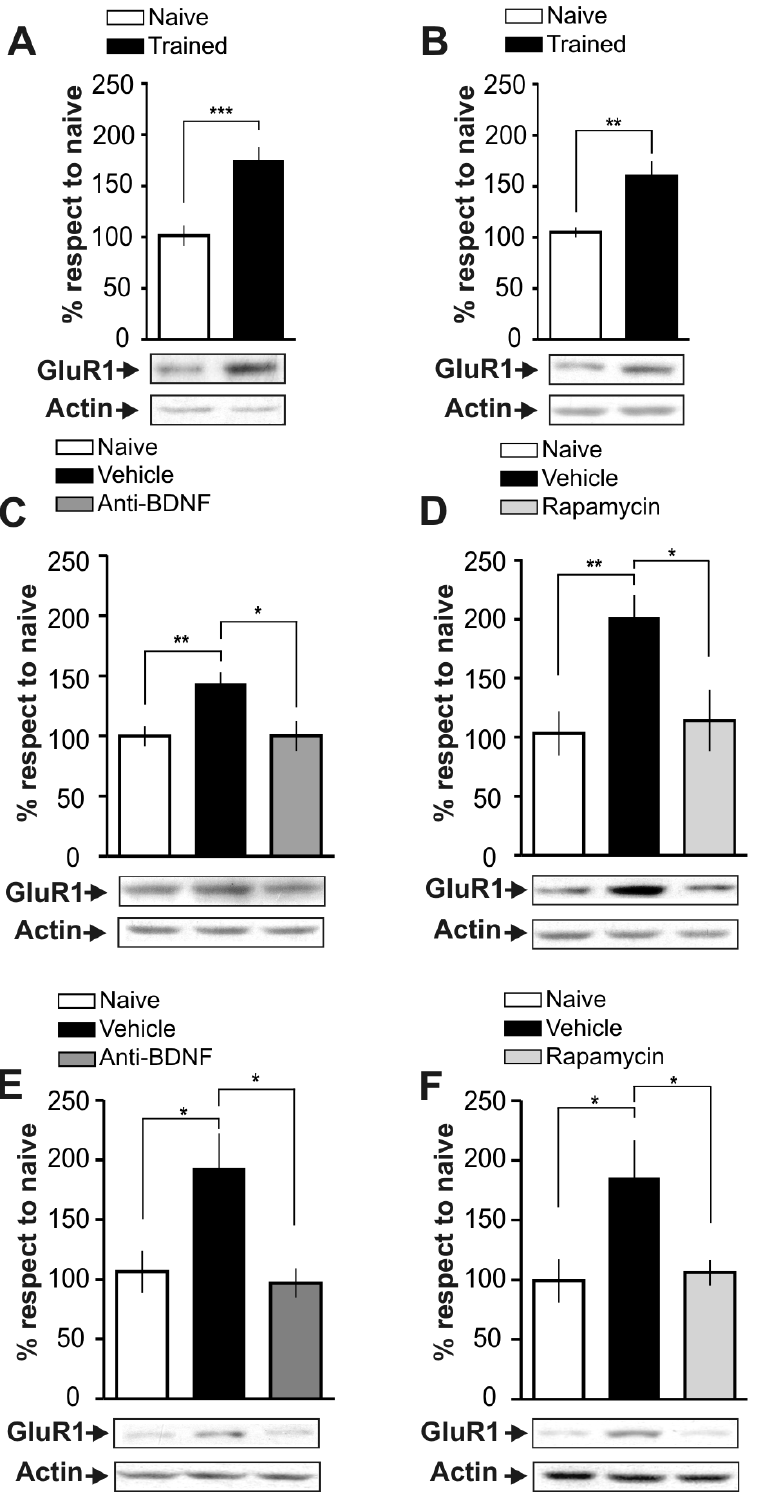
Figure 6. IA Training Induces GluR1 Expression in Hippocampal Synaptic Plasma Membranes-Enriched Fractions Through BDNF/ mTOR Pathway. Bars represent the mean GluR1/actin ratio from synaptic plasma membranes-enriched fractions obtained from samples of the dorsal hippocampus of trained (black) respect to naı¨ve (white) rats 15 min (A) or 3 h after IA training (B). Rats infused intra-CA1 of the dorsal hippocampus 15 min before and sacrificed 15 min after training (B and C) or 2:45 h and sacrificed 3 h both after training (E and F) with vehicle (black) or function-blocking anti-BDNF antibodies (0.5 m g/side; dark grey) (C and E) or rapamycin (4.3 pg/side; light grey) (D and F). Representative blots of total GluR1 protein levels and actin are shown in the lower panels *p , 0.05, **p , 0.01, ***p , 0.001, n=5–7 per group.